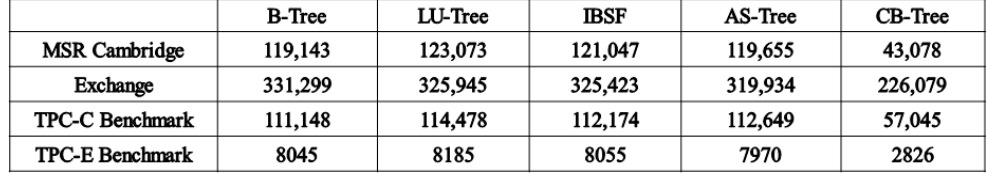
Figure 14. Total retrieval time in buffer-based B-trees.